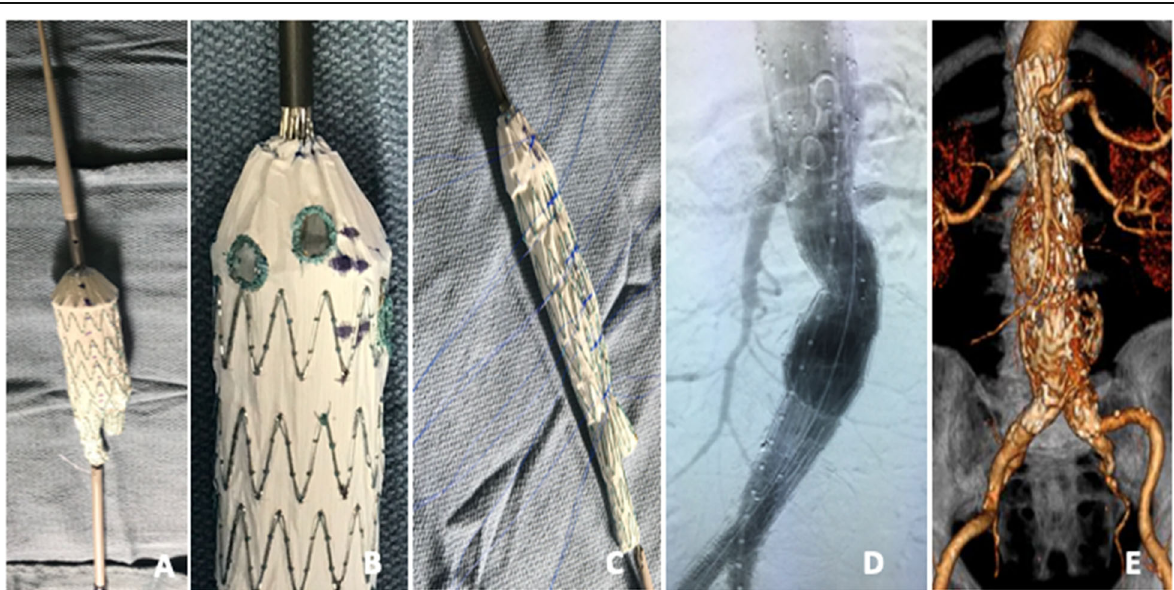
Fig. 2 Steps involved in the modification of the Zenith Flex AAA bifurcated main body. The device is deployed on a sterile back table and one of the 3 nitinol wires is withdrawn from the inner cannula ( A ). Fenestrations are created using an ophthalmologic cautery and reinforced with a radiopaque snare using 4 – 0 Ethibond locking sutures ( B ). The nitinol wire is redirected through and through the fabric and the device